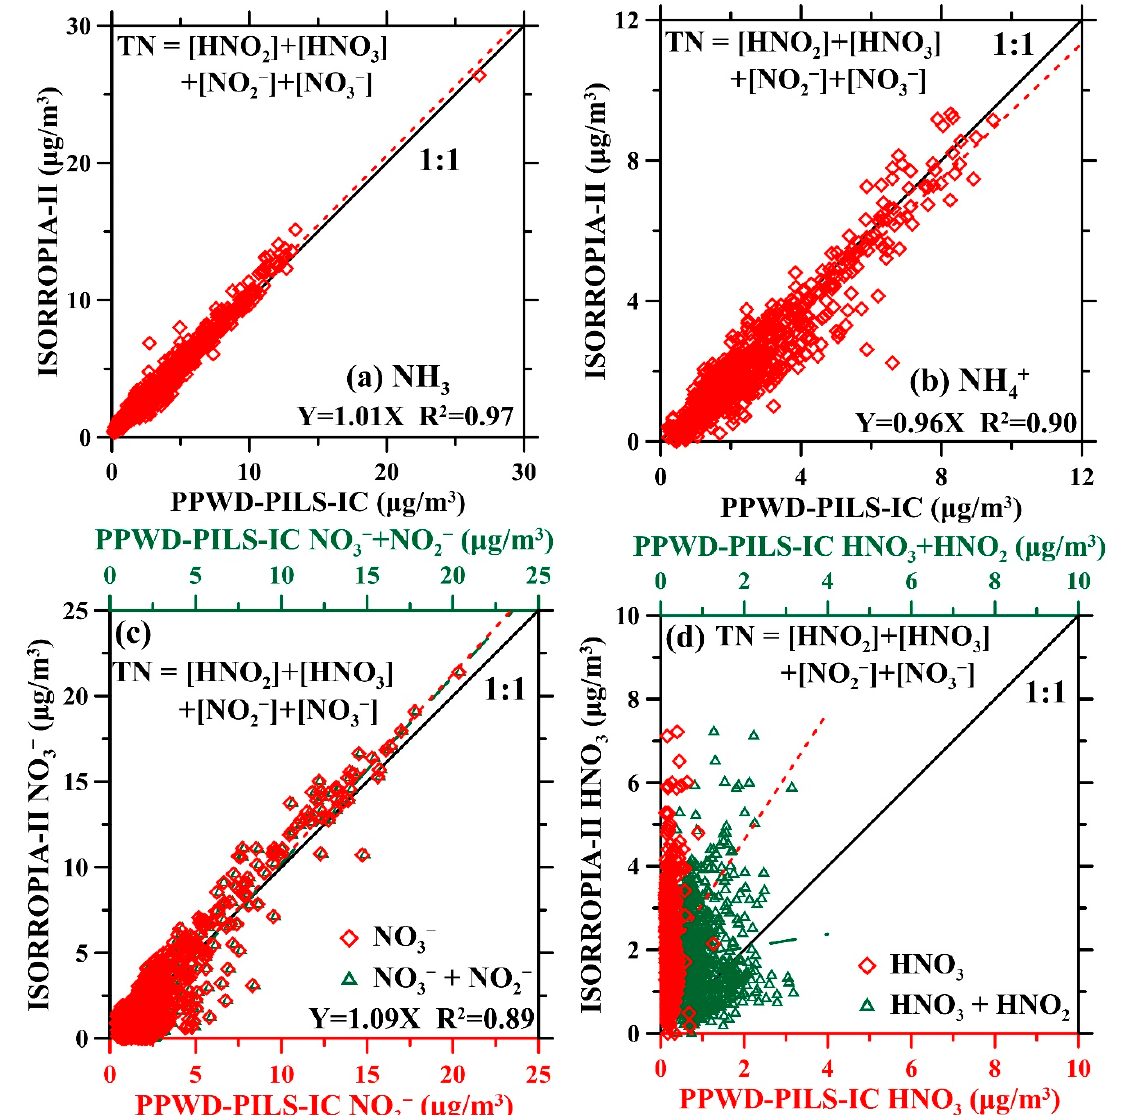
Figure 10. Correlation plot of the predicted results of the ISORROPIA-II thermodynamic equilibrium model and the observed data of the PPWD-PILS-IC for ( a ) NH 3 ; ( b ) NH 4 + ; ( c ) NO 3 − and NO 3 − + NO 2 − ; and ( d ) HNO 3 and HNO 3 + HONO 2 when TN = [HNO 3 ] + [NO 3 − ] + [HONO] + [NO 2 − ].